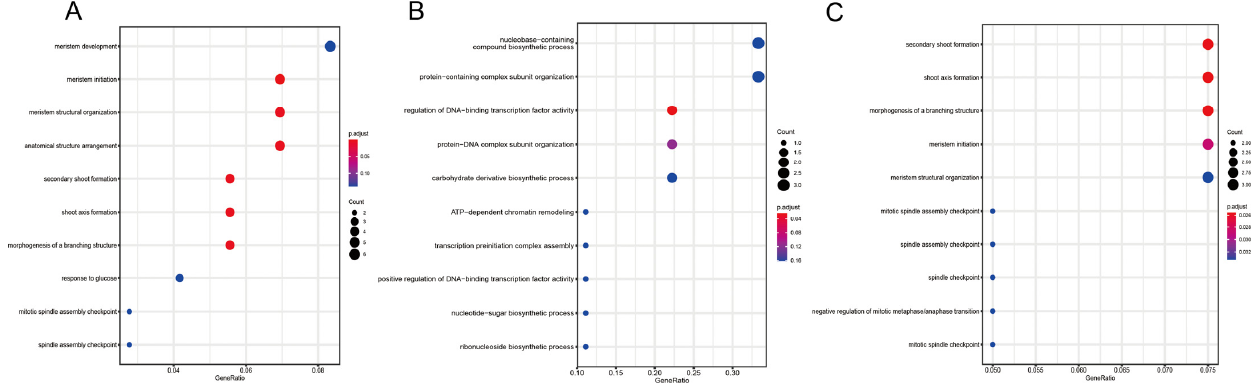
Figure 9. GO enrichment of JcLBD target genes. ( A – C ) are the downstream target genes of JcLBD27, JcLBD24 and JcLBD22,